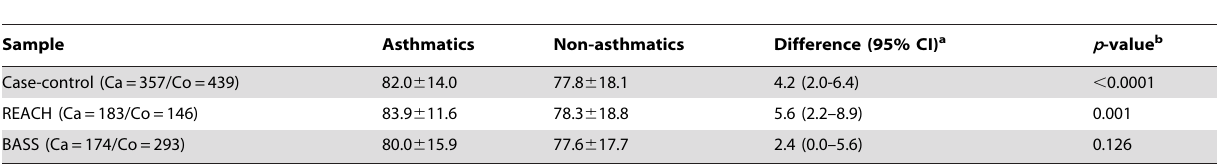
Table 1. Differences in African ancestry estimates (%, mean 6 SD) among case-control samples.